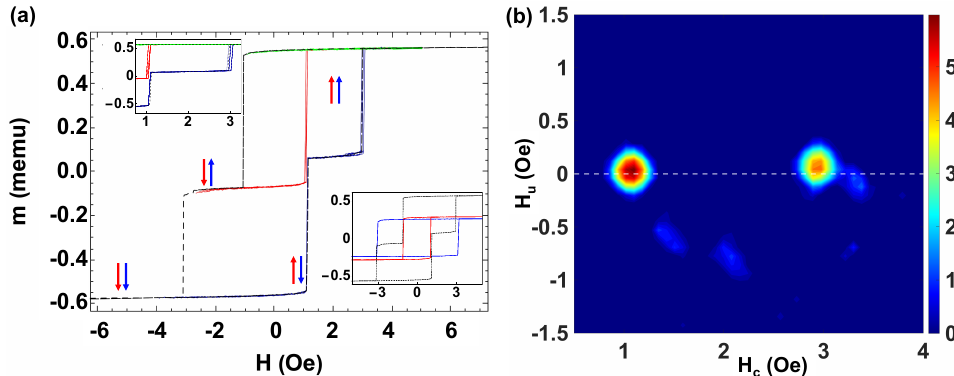
Figure 3. ( a ) FORC curves for two Fe 77.5 B 15 Si 7.5 microwires with very different coercive fields. At the inset, the MHLs of each microwire are depicted (red and blue lines) as well as the loop (black line) when both microwires are placed together. ( b ) Corresponding FORC